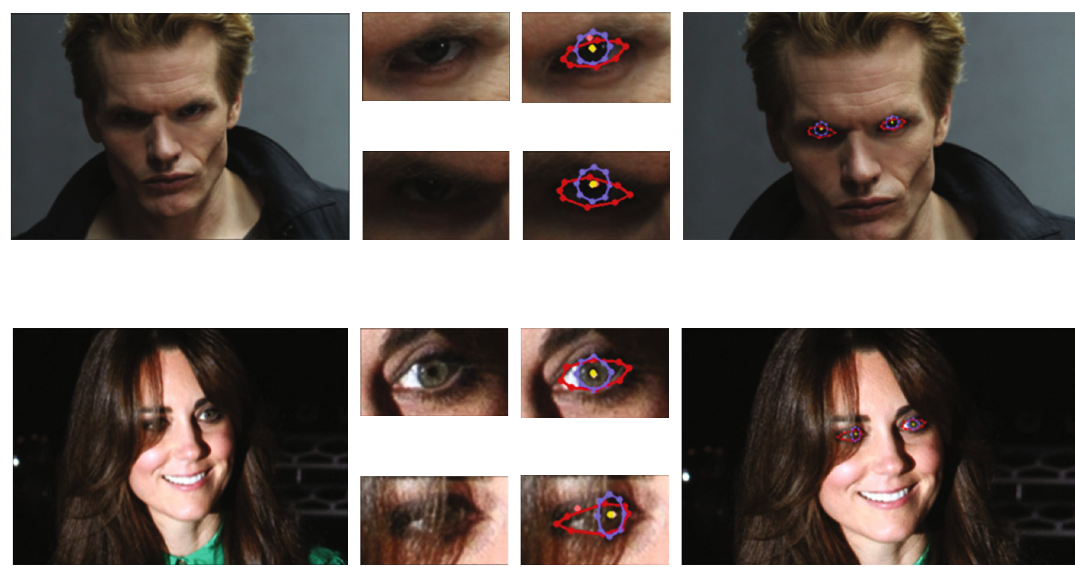
Figure 4: Eye features are extracted under dark condition and occlusion condition.